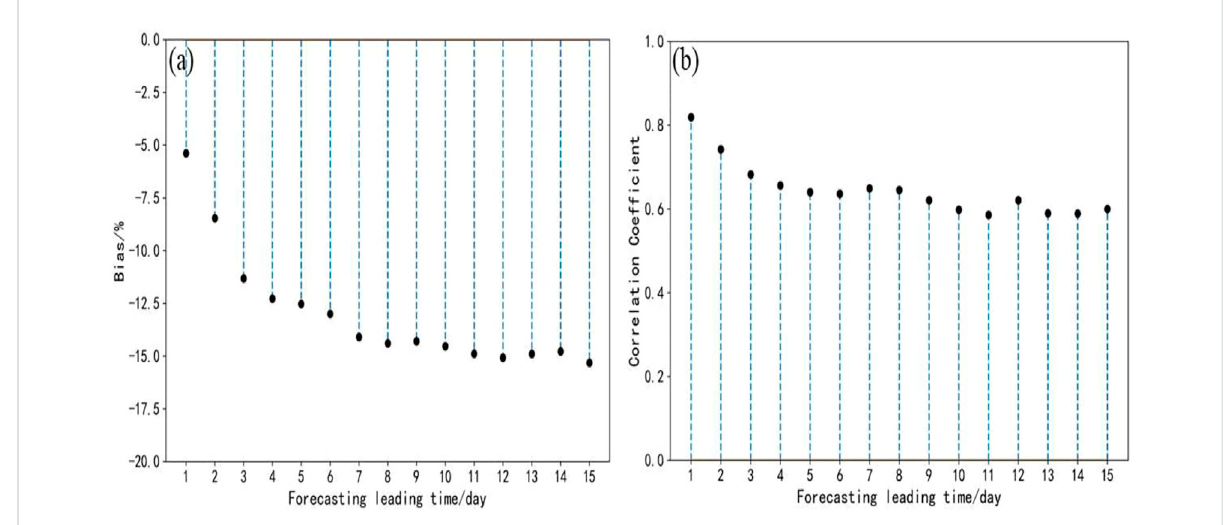
TABLE 3 The fi rst, second and third quartiles of forecasted PM 2.5 pollution ratios with different forecast leading times. Forecast leading time (unit: day)